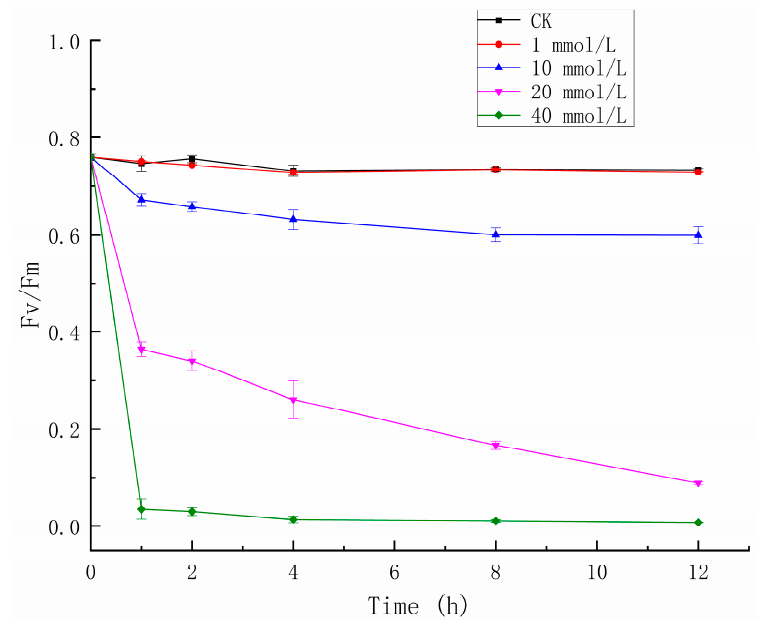
Figure 1. Effects of glyphosate on the photosynthetic activity (Fv/Fm) in Chlorella vulgaris . 3.2. The Effects of Glyphosate on the Contents of Photosynthetic Pigments Chlorophyll a, as the central pigment of the photosynthetic system, plays an important role in the light reaction in the photosynthetic process, so it is necessary to study the effect of the herbicide glyphosate on the chlorophyll a content. Figure 2 showed that low concentrations of glyphosate (1 mM) had little effect on chlorophyll a content in algae, with no significant differences compared to the control. Medium concentrations of glyphosate (10 mM and 20 mM) decreased the chlorophyll a content of algae, and their inhibitory effect increased with concentration. The high concentration of glyphosate (40 mM) had the greatest effect on the chlorophyll a content, and its chlorophyll a content was only 1/10th of that of the control samples.